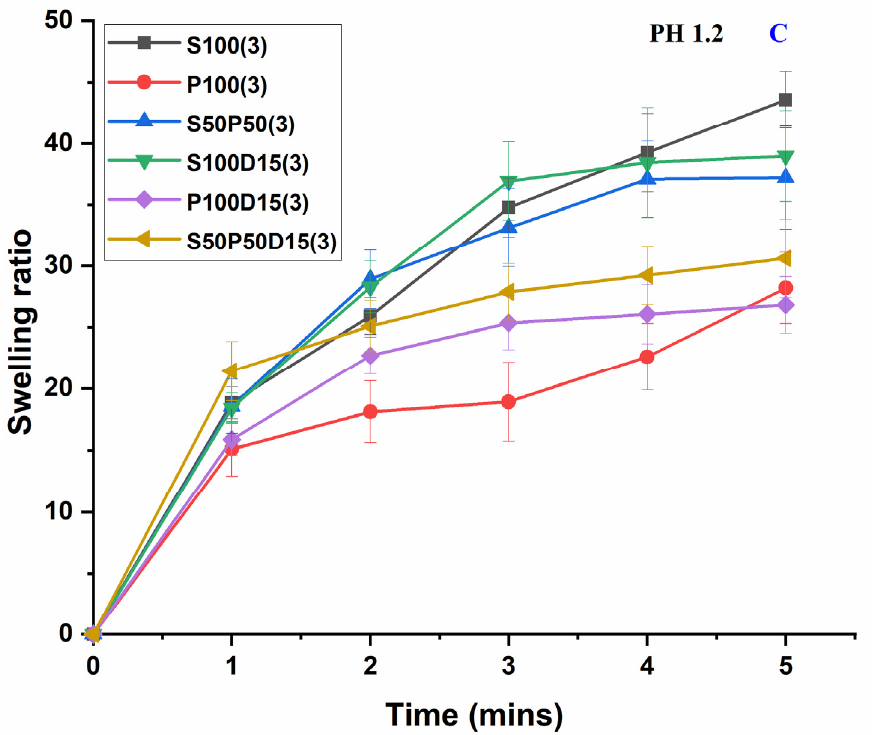
Figure 6. Swelling ratio of drugloaded (and unloaded) SA/PVA-MMT clay-reinforced nanocomposite films in ( A ) 1× PBS, pH 6.8, ( B ) NaOAc solution, pH 4.5, and ( C ) HCl solution, pH 1.2 .